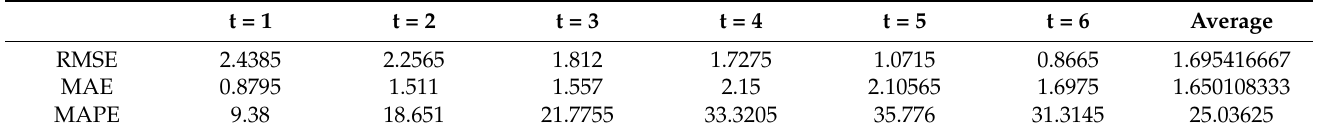
Table 11. Performance results of different univariate hybrid WSP models for Southern Offshore region TX.